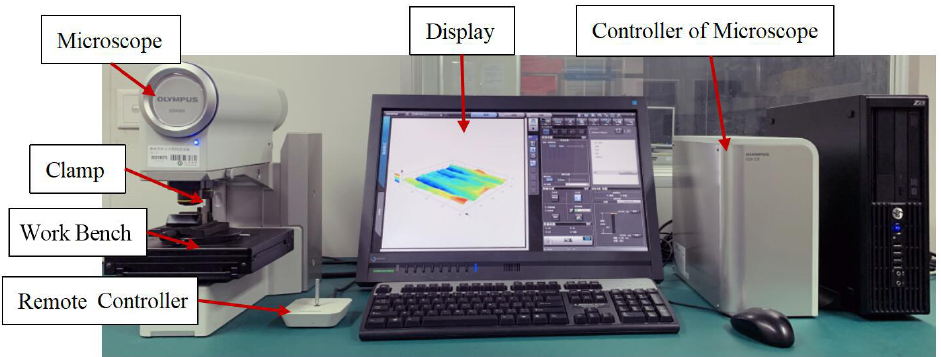
Figure 1. OLYMPUS-DSX500 optical digital microscope.